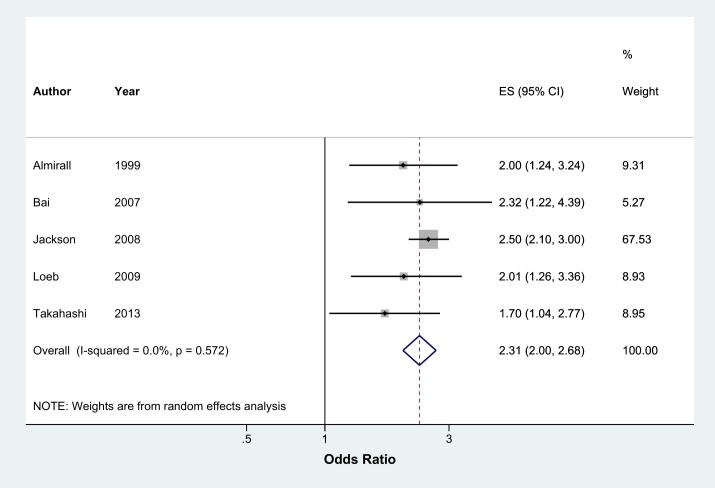
Meta-analysis of risk of community acquired pneumonia in current smokers relative to 'ever' smokers (Odds Ratio).Grey box = effect estimates from single studies. Diamond = pooled result with confidence interval. Vertical line at ‘1’ on the x-axis is the line of no effect. Weight (in %) = influence an individual study had on the pooled result.